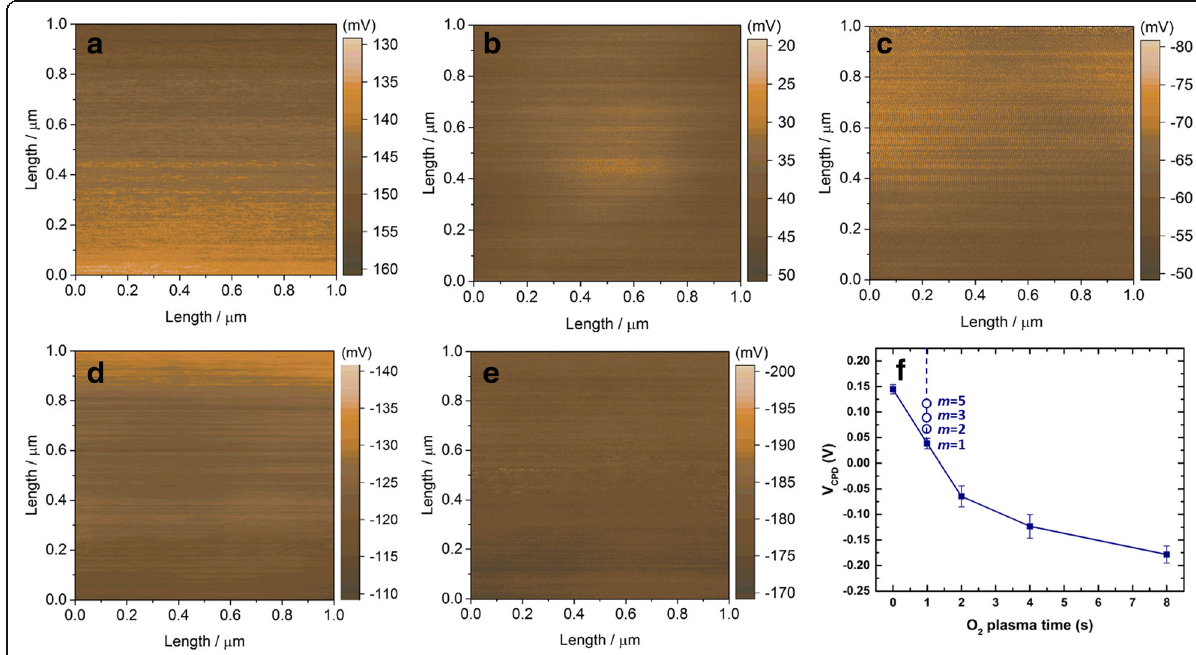
Fig. 4 a – e Two-dimensional contact potential difference V CPD images of the surface potential measurements of the supercycled ALD-grown